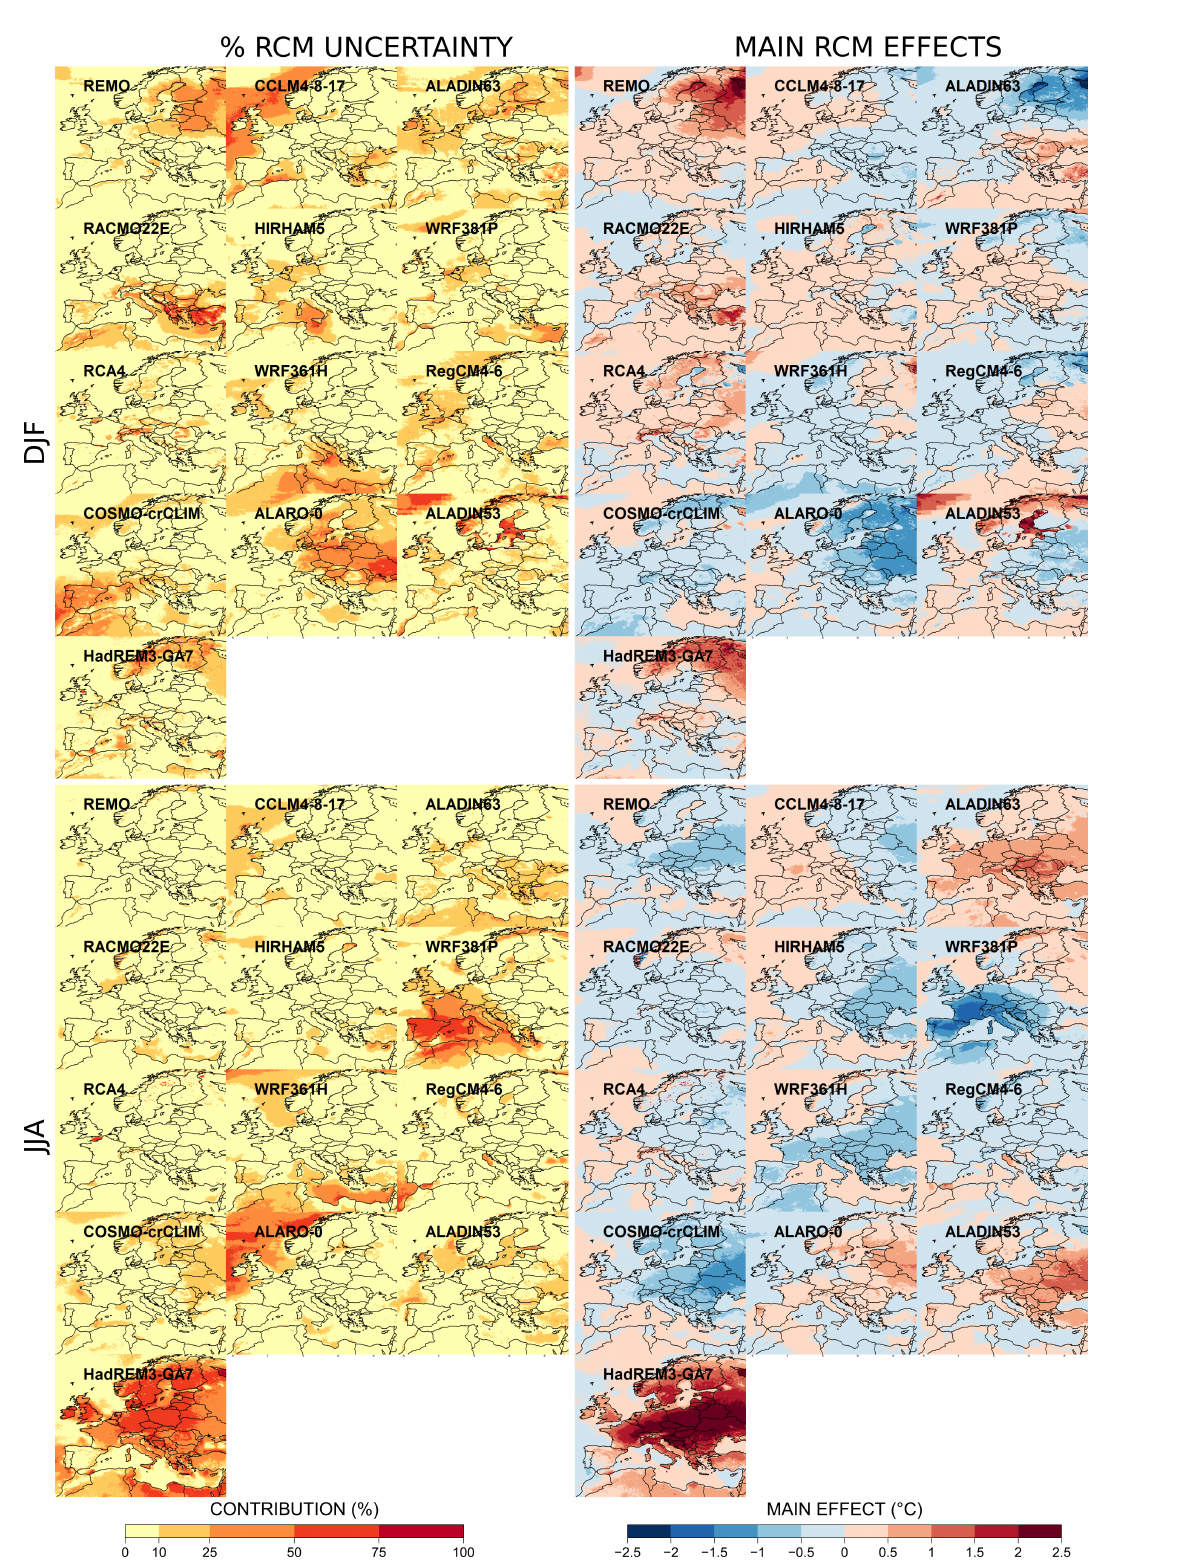
Figure 11. Fraction of RCM uncertainty (left plots) and main RCM effects (right plots) for each RCM for absolute temperature changes in winter (DJF) and summer (JJA) at the end of the 21st century (2071–2099) compared to the period 1981–2010.